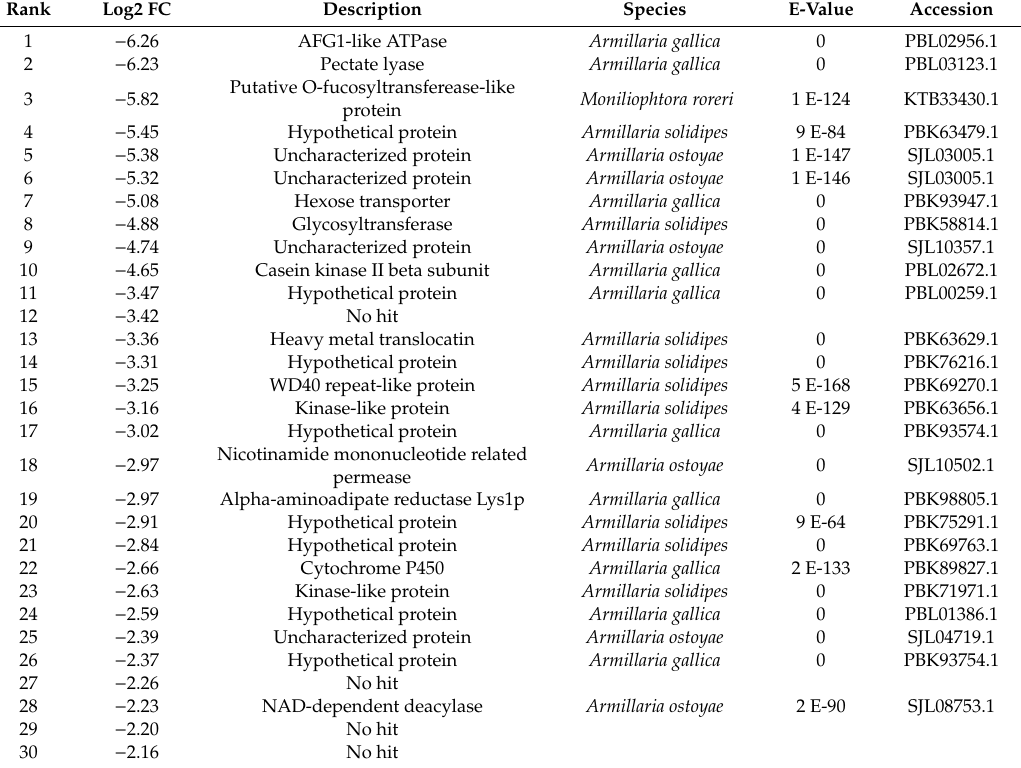
Table 5. Top 50 down-regulated transcripts of A. sinapina in cells cultivated in the presence of